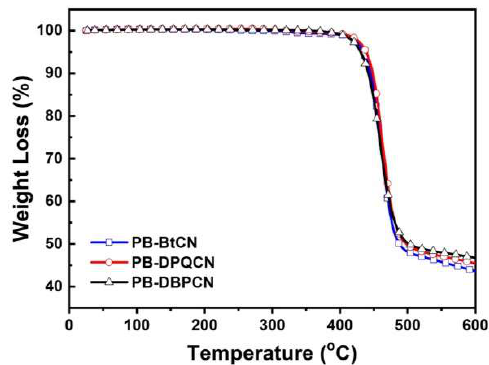
Figure 2. TGA curves of the polymers under N 2 at a heating rate of 10 °C/min.